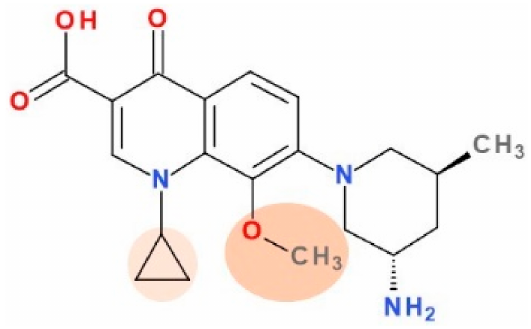
Figure 10. Chemical structure of nemonoxacin.